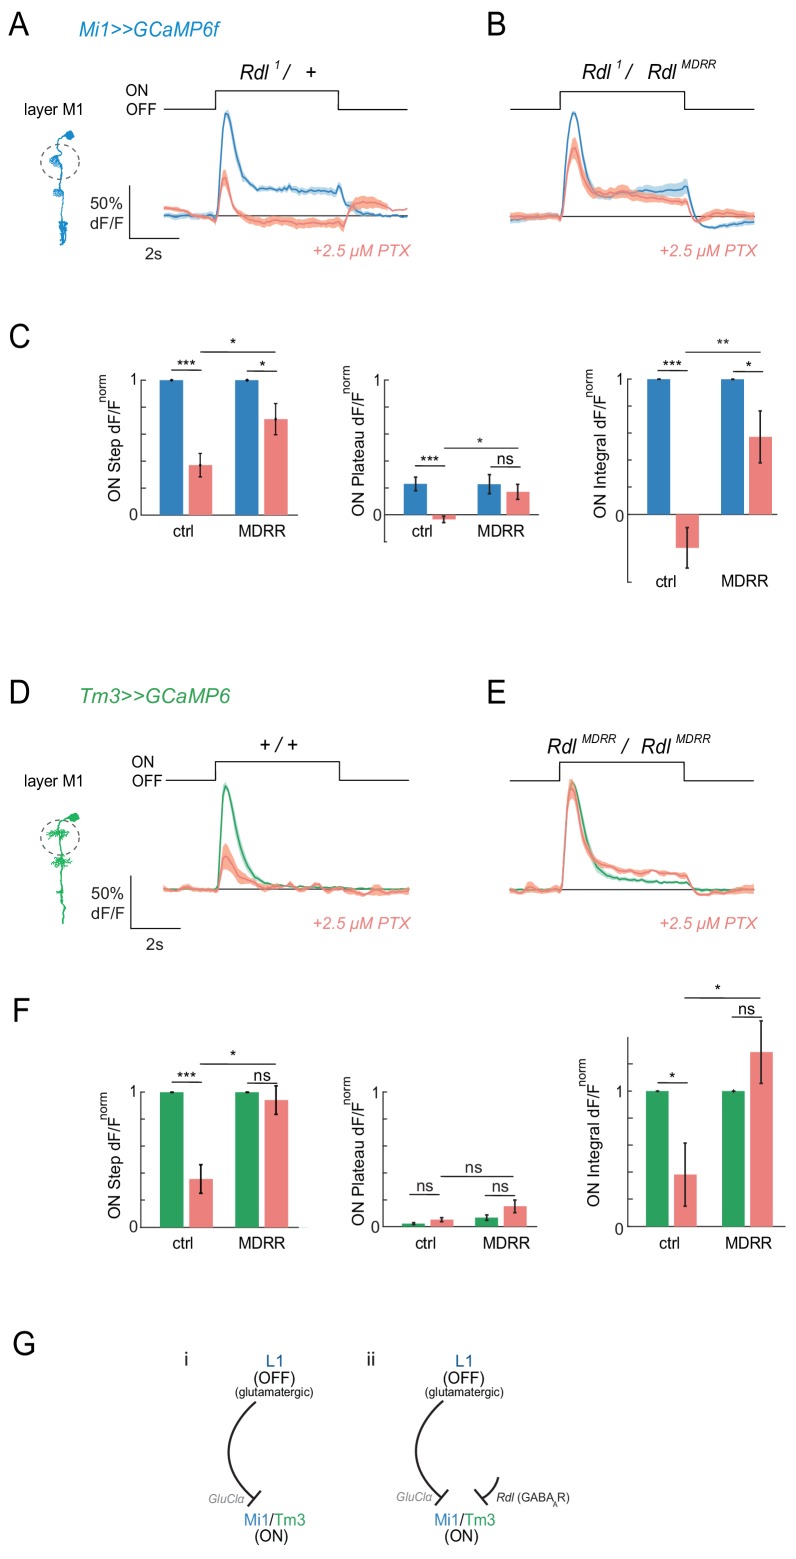
Pharmacogenetics shows that ON responses are partially mediated by the GABAAR Rdl.(A,B) In vivo calcium signals in response to full-field flashes recorded in layer M1 of Mi1 neurons. Figure shows traces before (blue) and after (red) 2.5 µM PTX application in heterozygous Rdl1/+ controls (A, n = 7 (58)), or flies only expressing the PTX-insensitive RdlMDRR allele (Rdl1/RdlMDRR) (B, n = 8 (77)). (C) Bar plots showing the quantification of the normalized ON step, ON plateau and ON integral of the data shown in (A,B). *p<0.05, **p<0.01, ***p<0.001, tested with an unbalanced two-way ANOVA, corrected for multiple comparisons. (D,E) In vivo calcium signals in response to full-field flashes recorded in the layer M1 of Tm3 neurons. Genotypes: ctrl = Rdl1/+ and 1 = Rdl1/RdlMDRR. Figure shows traces before (green) and after (red) PTX application +/+ controls (D, 1 = 5[34]), or flies only expressing the PTX-insensitive RdlMDRR allele (RdlMDRR/RdlMDRR) (E, n = 5[46]). (F) Bar plots showing the quantification of the traces shown in (D,E). All traces show mean ± SEM. Sample sizes are given as number of flies (number of cells). *p<0.05, **p<0.01, ***p<0.001, tested with an unbalanced two-way ANOVA, corrected for multiple comparisons. (G) Schematic summarizing the results. Our results suggest that ON-selectivity does not arise solely through glutamate-gated chloride channels as initially thought (i). The GABAAR Rdl is required for ON-responses in a pathway parallel to the monosynaptic L1-Mi1/Tm3 connection (ii).10.7554/eLife.49373.018Figure 4—source data 1.Table 1 contains all mean ± s.e.m.Data related to quantifications shown in main Figure 4, sorted by genotype and experimental condition.